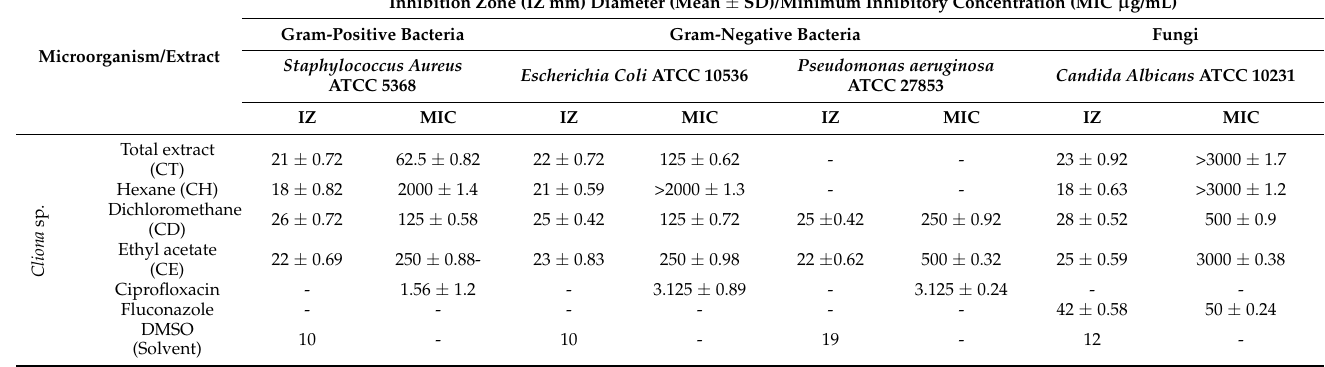
Table 4. Antimicrobial activity of Cliona sp. Total extract (CT), Hexane (CH), Dichloromethane (CD), and Ethyl acetate (CE) fractions by agar diffusion method.